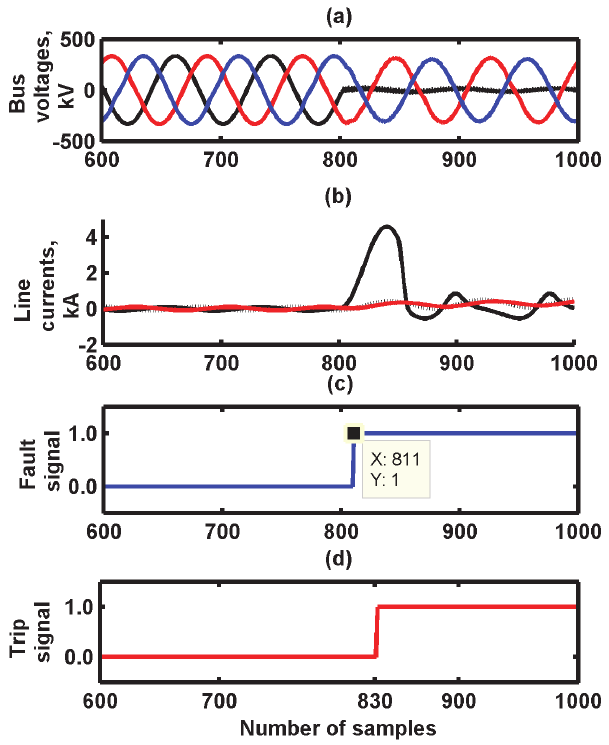
Fig. 12. Wave forms of (a) bus voltages, (b) line currents, (c) fault signal, (d) trip signal during close-in fault at 5 km with FIA = 0° with CT secondary burden of 15